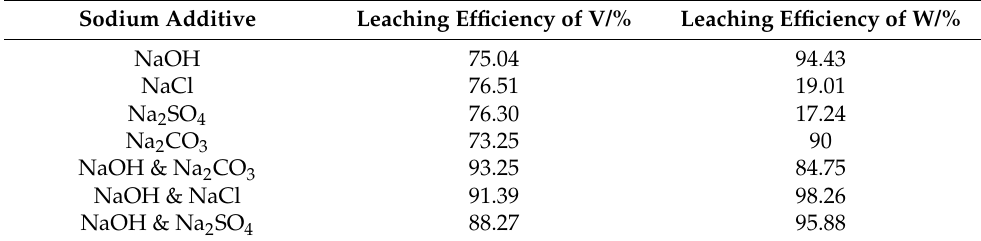
Table 2. The effect of different sodium additives on the leaching efficiencies of vanadium and tungsten. Sodium Additive